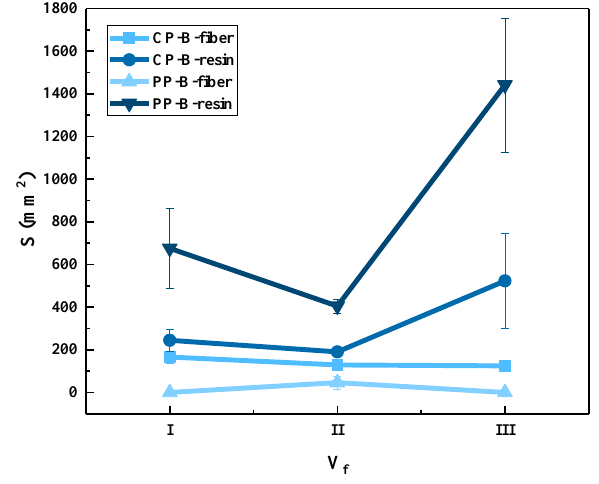
Figure 10. Fiber/resin damage areas of samples after ballistic test of back face. Figure 11 shows the height variation of the different regions on the back face of the 3DWCs obtained by 3D contour scanning. There are obvious differences between the PP case and the CP case. The height variation for CP was concentrated in an area with a diameter of 10–20 mm centered on the shooting point. The PP case shows a height cloud map approximating concentric circles. With the increase of V f , the range of the